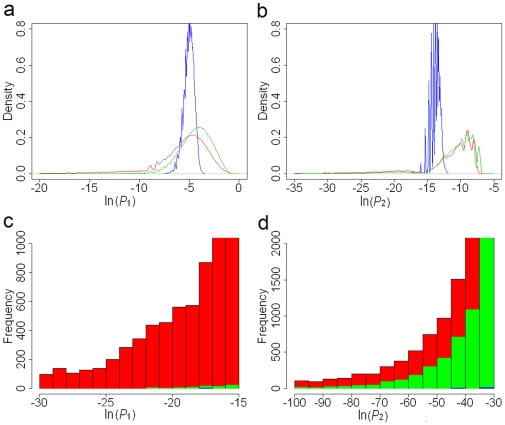
Density distributions and histograms of probabilities derived from our method.Red lines and bars: probabilities calculated from the human PPI network; green lines and bars: probabilities from truncated power law–preserving random networks; blue lines and bars: probabilities from simple random networks. (a) Density distributions of P
1. (b) Density distributions of P
2. (c) Histograms of P
1. (d) Histograms of P
2.